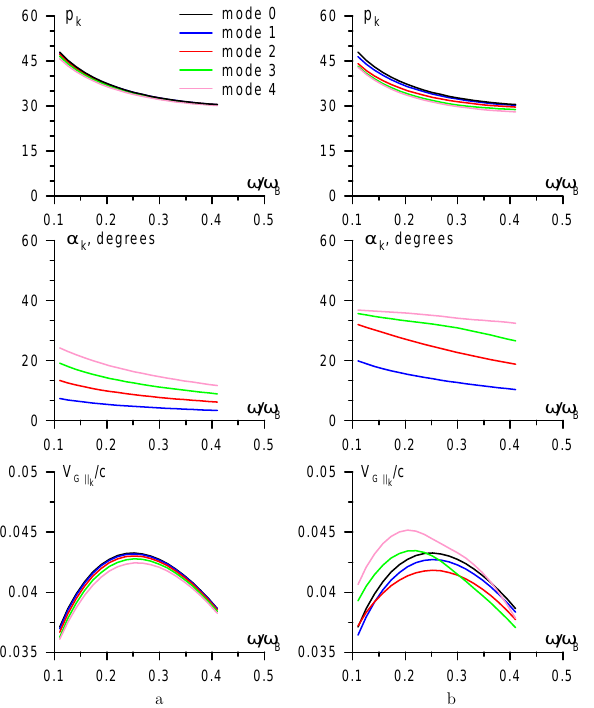
Fig. 2. Dependencies of eigenmode parameters on the frequency in the cases of wide ( a ) and narrow ( b ) ducts: a − κa = 35, b − κa = 10; eigenmode indexes are shown on the legend, index 0 corresponds to the whistler, propagating along the magnetic field in the plasma with parameters of the duct core; other parameters: ω p 1 = 1 . 25.